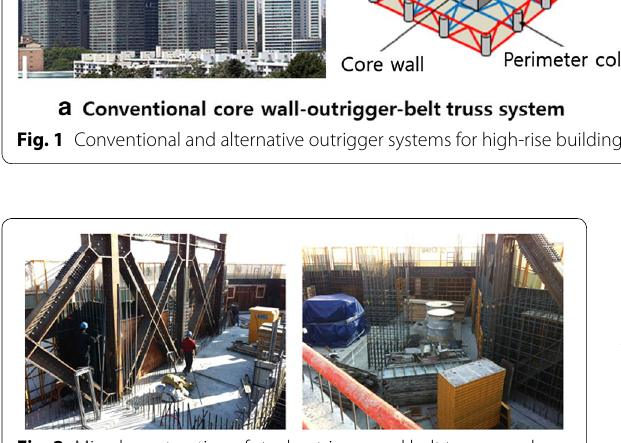
Fig. 2 Mixed construction of steel outrigger and belt trusses and reinforced concrete core wall and